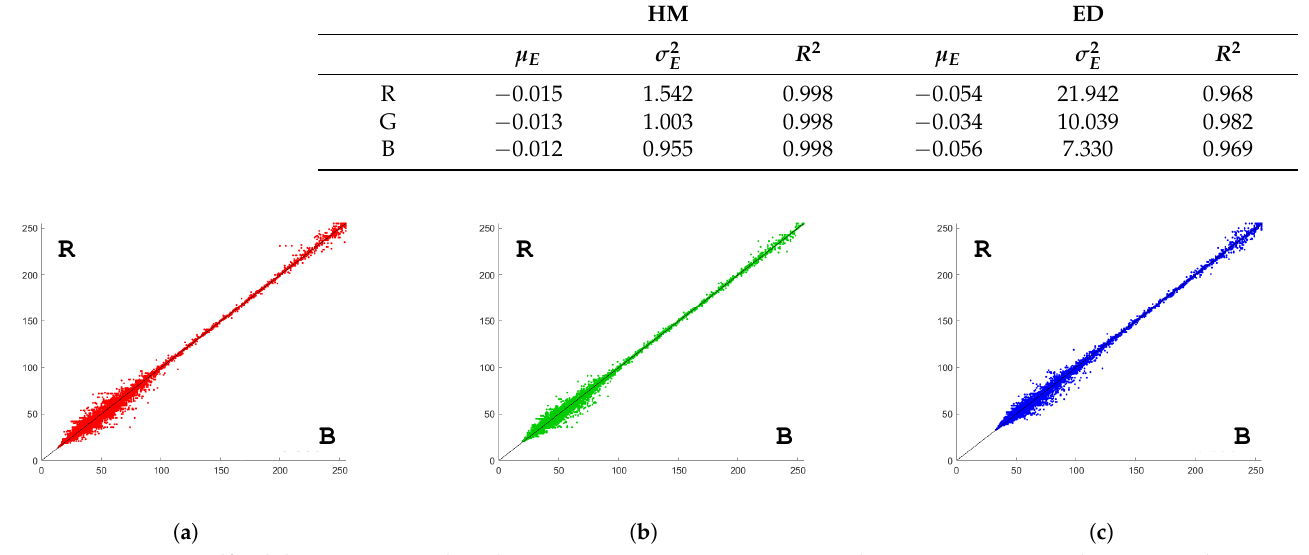
Table 3. Error characteristics of RGB self-validation tests with ( α , λ ) = ( 1200,8 ) , reported for com- parison with Table 2; mean of intensity differences, variance of intensity differences, and coefficient of determination.